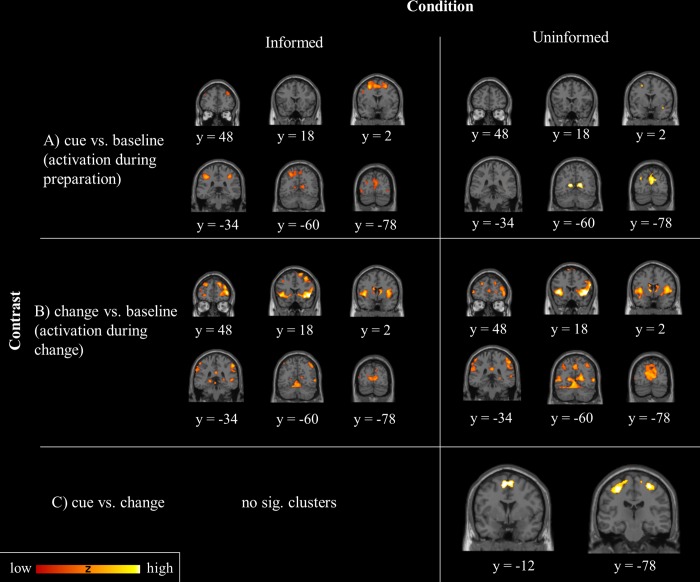
Activation during cue and change-signal presentation in the informed and uninformed condition.Rows present activation for the contrasts: A) cue vs. baseline, B) change vs. baseline, C) cue vs. change for the informed (left column) and uninformed (right column) condition. More reddish blobs represent lower Z values, while more yellowish blobs represent higher Z values. Slices are presented from rostral to caudal with y-coordinates assigned to MNI space. All activations were uncorrected on voxel level (p <0.0001, spatial extent threshold of 20 adjacent voxels).